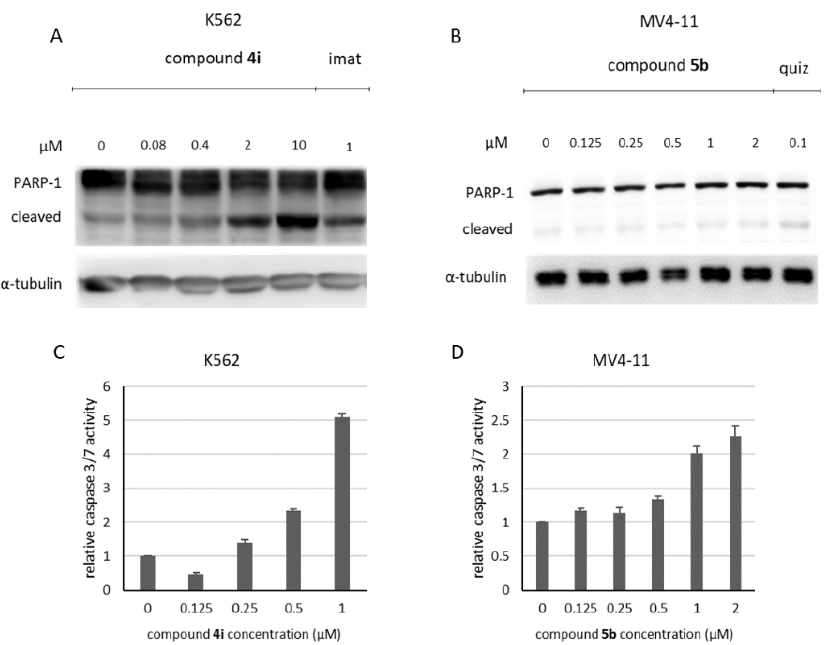
Figure 14. Detection of apoptotic marker PARP-1 and relative caspase 3/7 activity in cell lines treated with compounds 4i and 5b . Cleaved PARP-1 was detected in K562 treated with 4i ( A ) and in MV4-11 treated with 5b ( B ). Cells were treated for 4 h. Caspase 3/7 activity was measured in lysates of K562 ( C ) and MV4-11 cells ( D ) after 24 h treatment with the respective compounds.